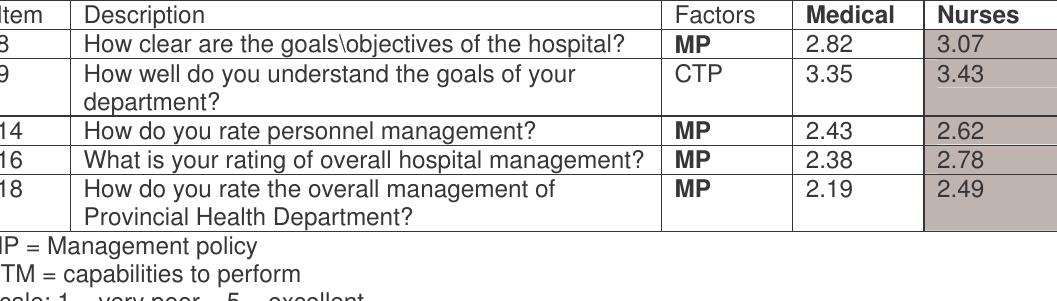
Table 6:Variables that explains satisfaction